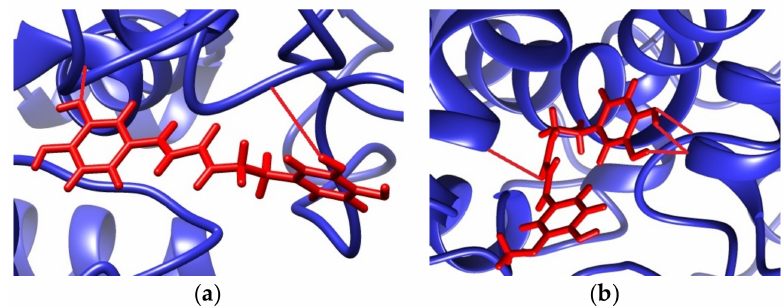
Figure 2. The complex target–ligand as viewed in UCSF Chimera 1.12. Possible interaction of AChE from E. electricus with: ( a ) N - trans -caffeoyldopamine; ( b ) N - trans